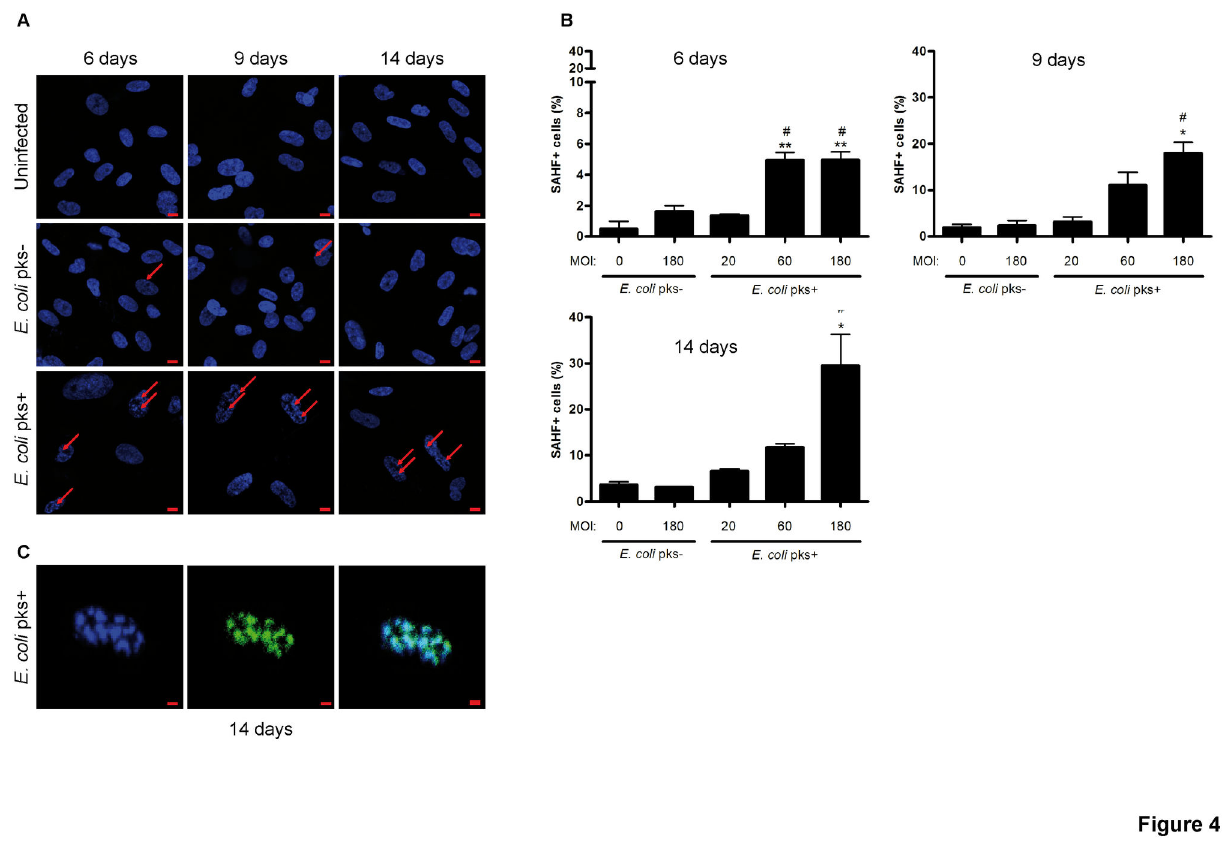
Figure 4. Accumulation of heterochromatin foci in IMR-90 cells infected with pks + E. coli. (A) Cells were stained with DAPI 6, 9 or 14 days after infection and examined for formation of heterochromatin foci (arrows) by confocal microscopy. Pictures of uninfected and MOI 180 –infected cells are shown, scale bars = 10µm. (B) Cells were stained with DAPI (blue) and with antibodies against H3K9me3 (green) 14 days after infection and examined by confocal microscopy, scale bar = 50µm. (C) Heterochromatin foci-positive cells (60-100 nuclei for each condition) were counted by a blinded observer. Results represent the mean and SEM of three independent experiments, one-way ANOVA with Bonferroni’s multiple comparison test; *P<0.05, **P<0.01 comparing infected and uninfected groups; #P<0.05 comparing pks + and pks -